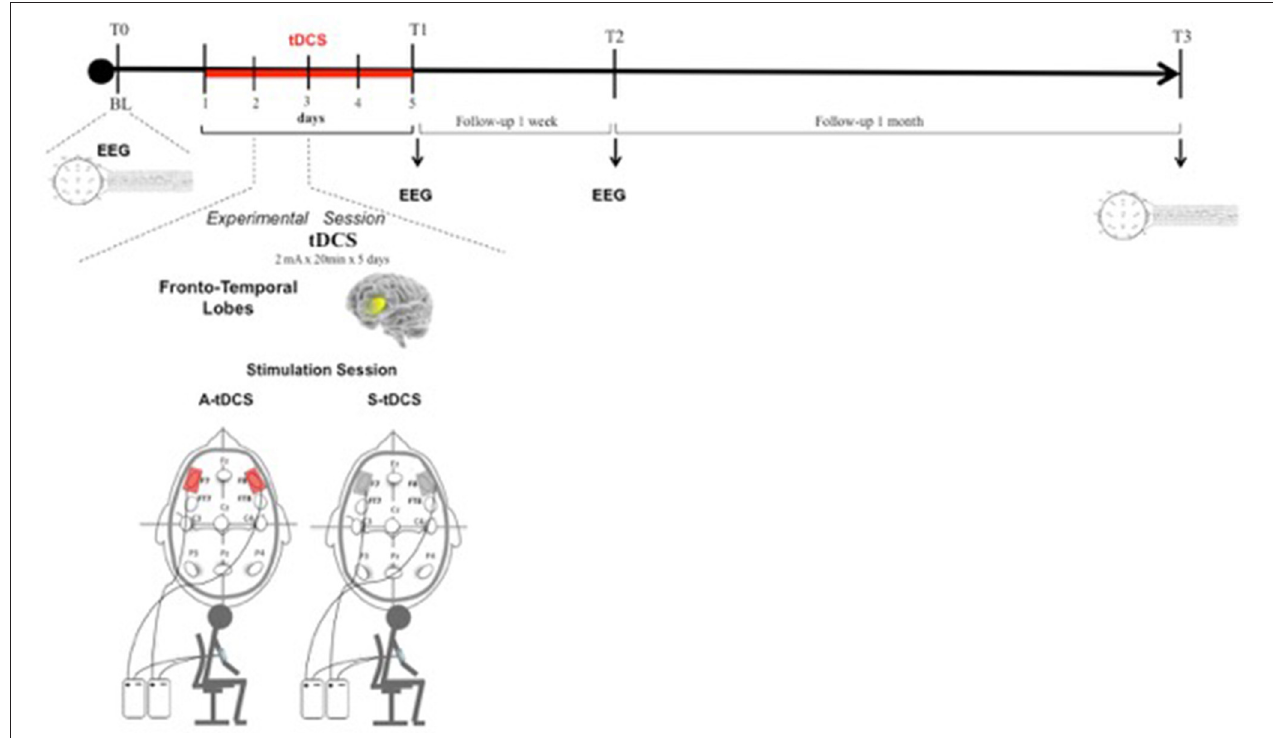
FIGURE 1 | Transcranial Direct Current Stimulation (tDCS) experimental protocol. tDCS was applied bilaterally over the scalp on the Fronto-Temporal lobes for 5 consecutive days. Patients were assessed at baseline (T0), after 5 consecutive days of treatment (T1), after 1 week (T2), and after 4 weeks (T3) from the end of tDCS